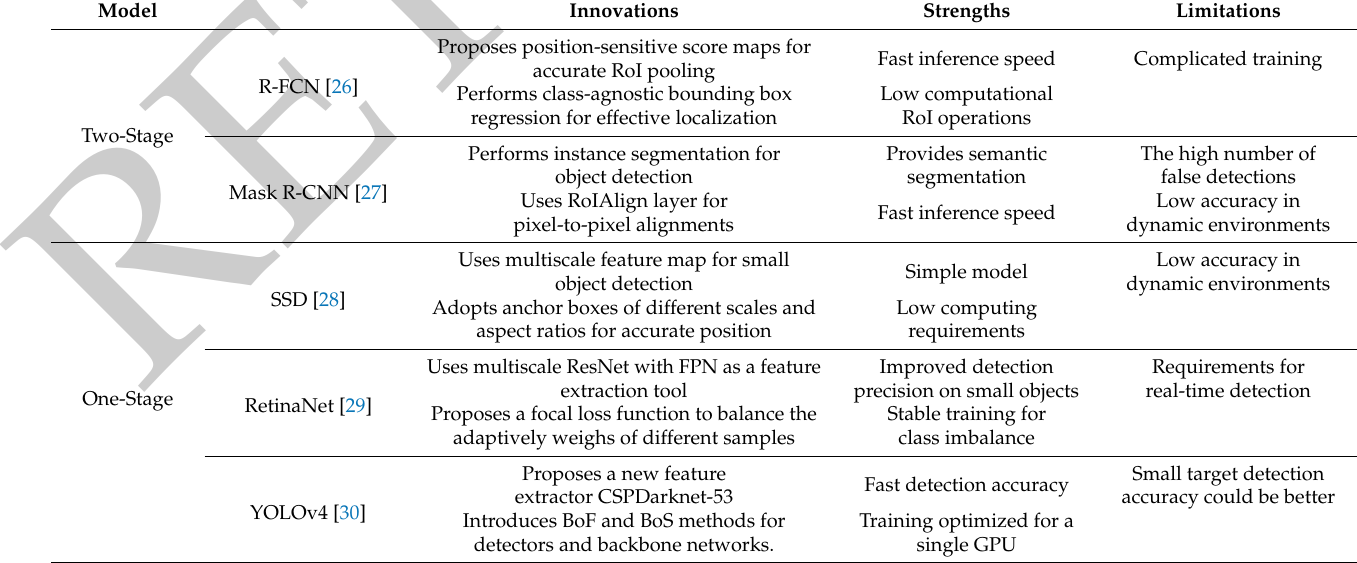
Table 2. Innovations with strengths and limitations of various two-stage and one-stage deep learning